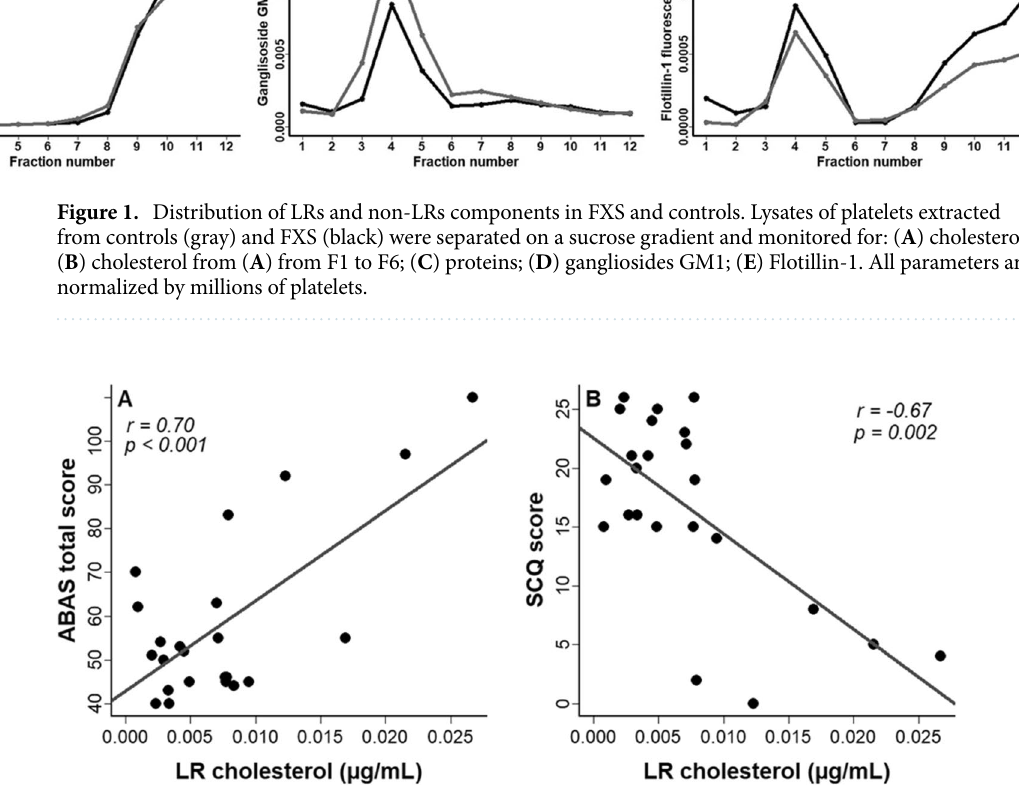
Figure 2. Association of LRs cholesterol with ( A ) ABAS total score and ( B ) SCQ score. r: Pearson correlation coefficient.